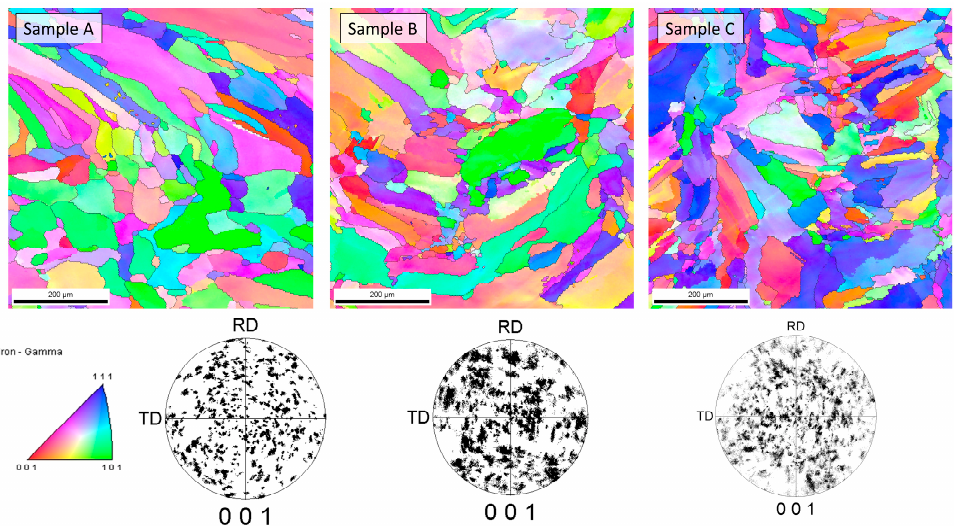
Figure 5. Results of EBSD analysis of samples.